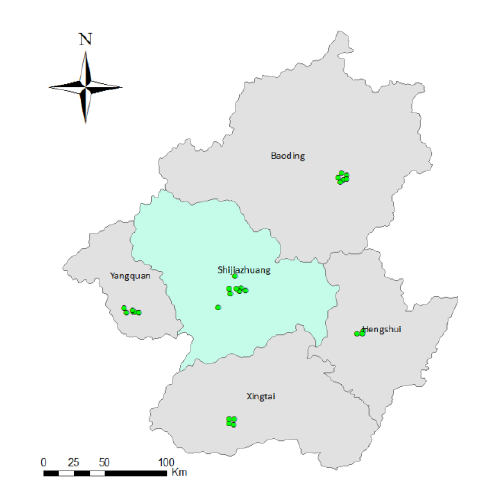
Figure 2. Location of environment monitoring